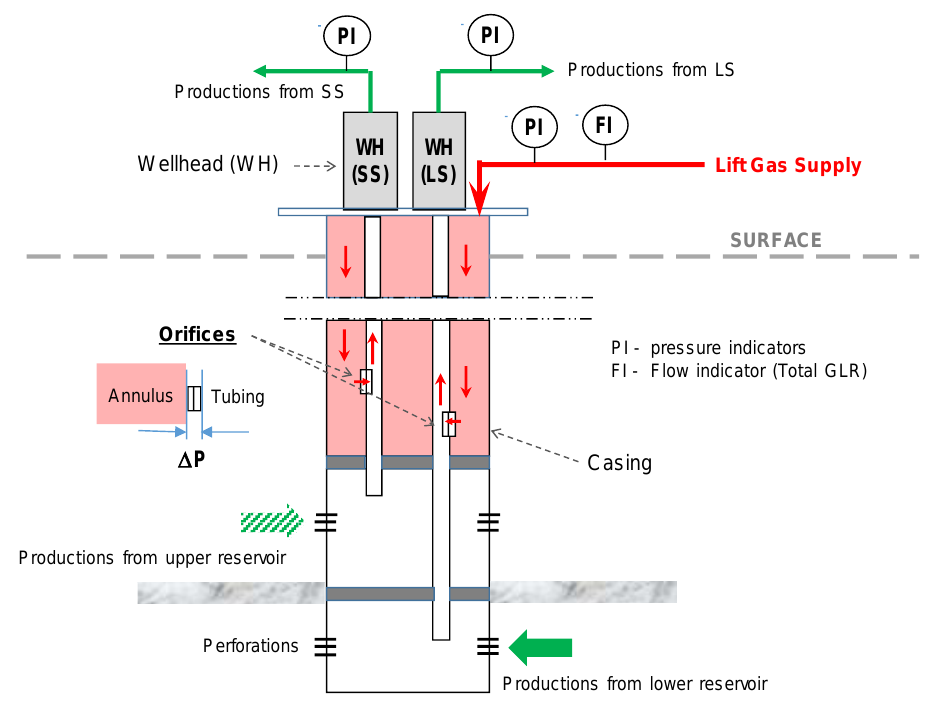
Figure 4. Relationship between casing, tubing and orifice pressure drop.